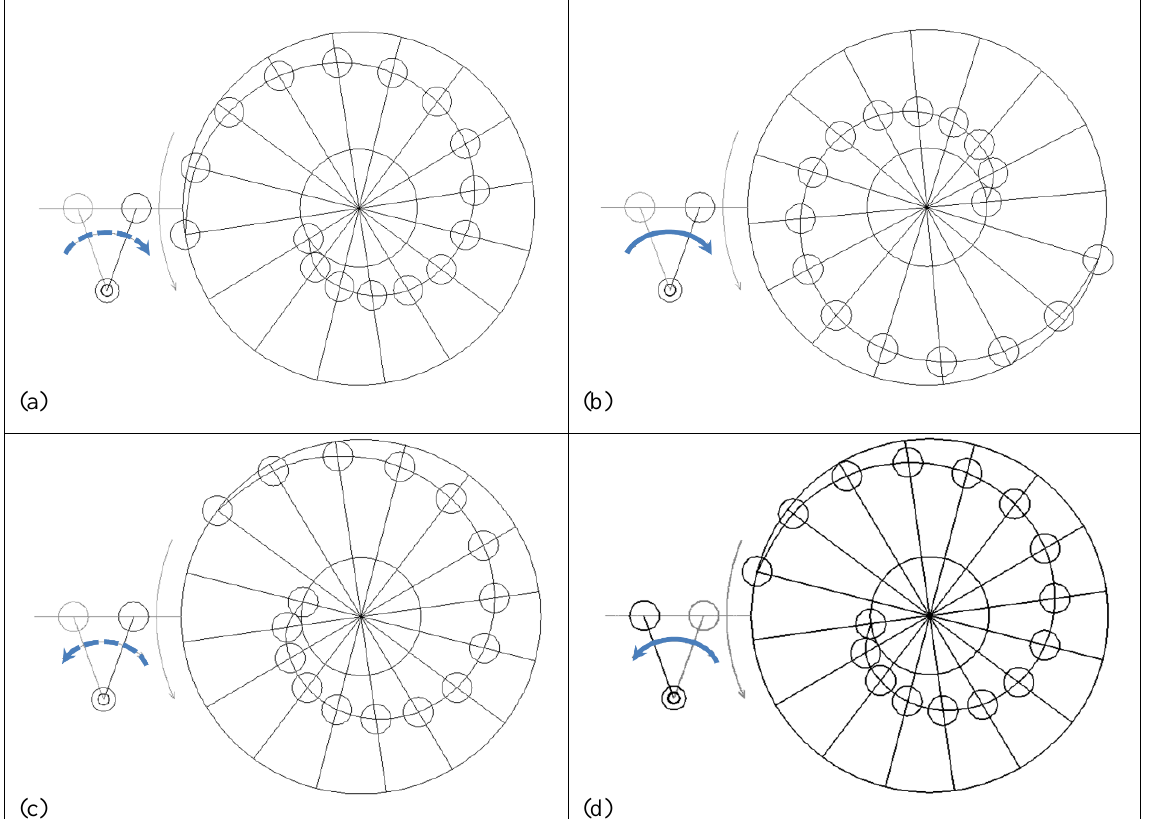
Figure 2. Sequential stages of the contactless crank-rocker machine operation; a: start-state of the cycle, b: middle-state of the cycle, c: before end-state of the cycle, d: last-state of the cycle